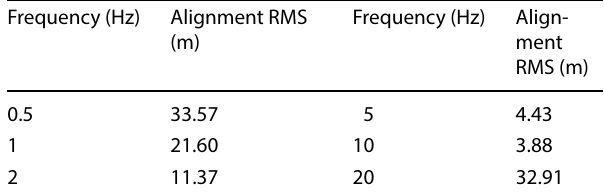
Table 2 Accuracy metrics for ICP at different data